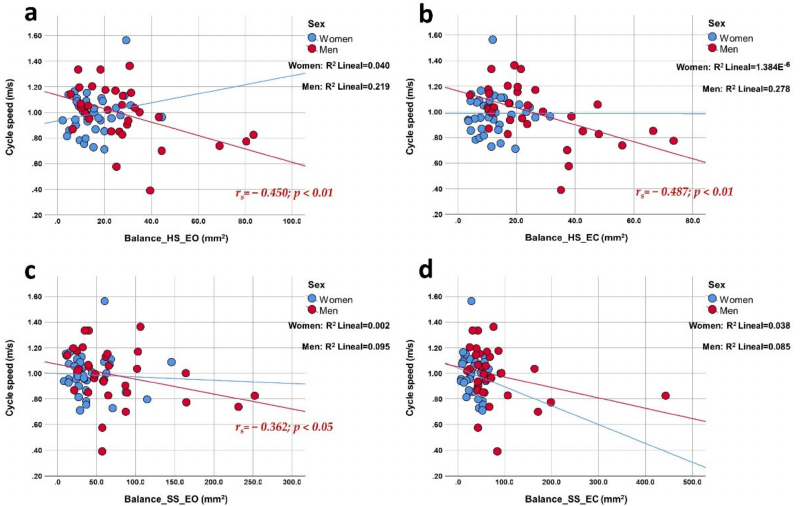
Figure 3. Correlation plots of gait cycle speed compared to balance area in each of the tests. Each image shows the correlations obtained distributed by sex. The upper part of the figure shows the results for a hard surface with eyes open (panel ( a ); linear R 2 women: 4.0%; men: 21.9%) and closed eyes (panel ( b ); linear R 2 women: 0.0%; men: 27.8%); the lower part shows the results for a soft surface with open eyes (panel ( c ); linear R 2 women: 0.2%; men: 9.5%) and closed eyes (panel ( d ); linear R 2 women: 3.8%; men: